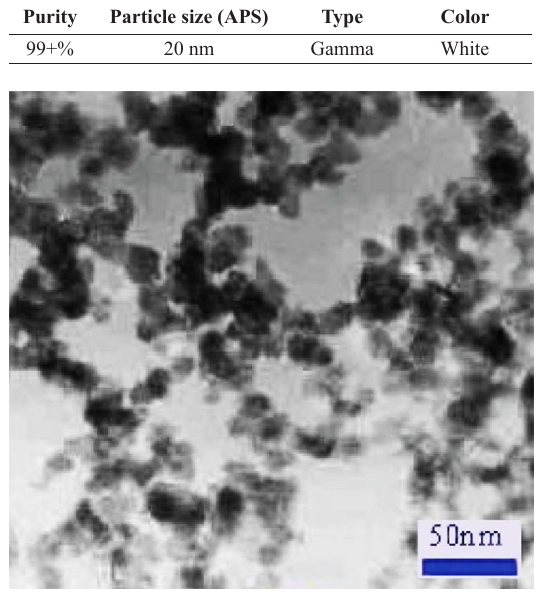
Figure 1. Micrograph of the as-received Al